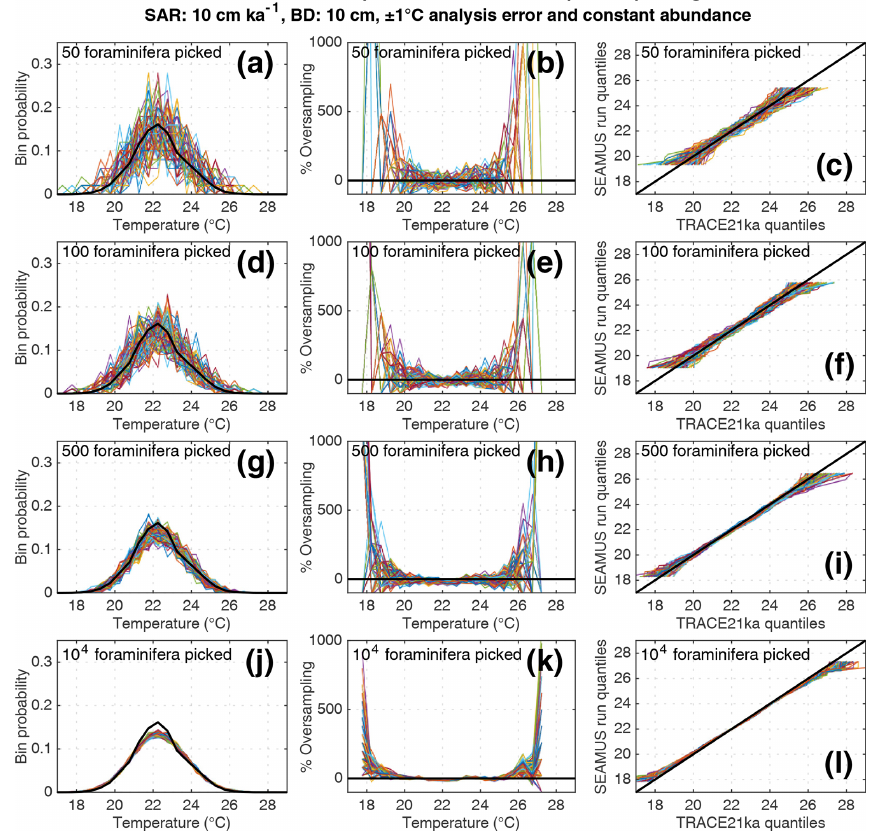
Figure 6. Simulated single foraminifera SST distributions from 100 ensembles of SEAMUS runs, with SAR of 10cmkyr − 1 , BD of 10cm, ± 1 ◦ C analytical error and constant abundance. In each ensemble, the single foraminifera SST distribution from a single discrete depth with a simulated median age of 17.5ka is compared to the TRACE-21ka SST distribution for the 18 to 17ka period. The left panels (a, d, g, j) show the 100 SEAMUS ensembles as coloured lines in the case of 50, 100, 500 and 10 4 randomly picked foraminifera, with the TRACE-21ka SST distribution shown as a black line. The middle panels (b, e, h, k) show the rate of oversampling/undersampling for each of the 100 SEAMUS ensembles (coloured lines) relative to the TRACE-21ka SST distribution (black line) in the case of 50, 100, 500 and 10 4 randomly picked foraminifera. The right panels (c, f, i, l) show Q–Q plots of the 100 SEAMUS ensemble quantiles vs the TRACE-21ka quantiles as coloured lines in the case of 50, 100, 500 and 10 4 randomly picked foraminifera, with a perfect 1:1 correspondence to TRACE-21ka shown for reference as a black